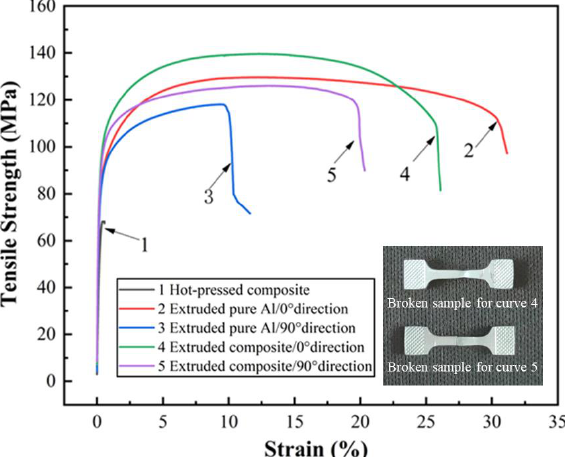
Figure 15. Representative tensile stress–strain curves of composites hot-pressed and extruded by the porthole die.